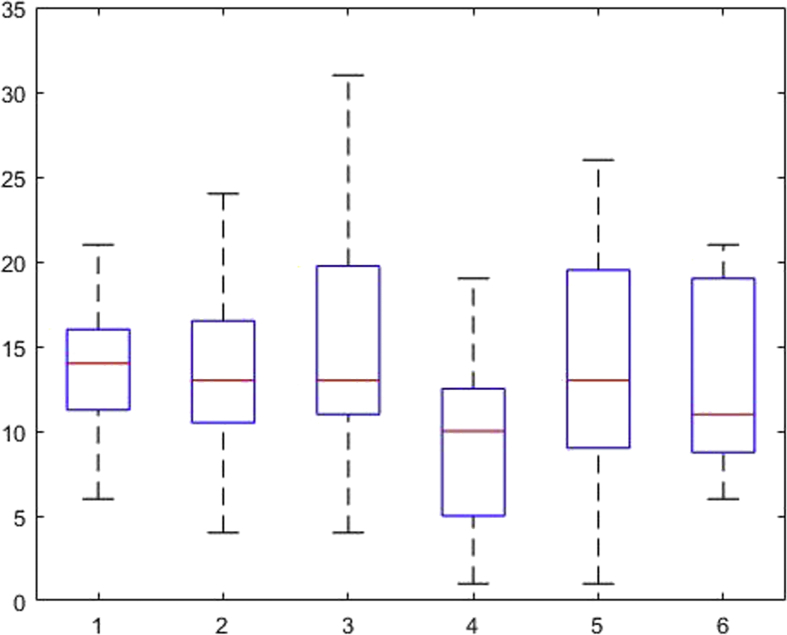
Details immediate.